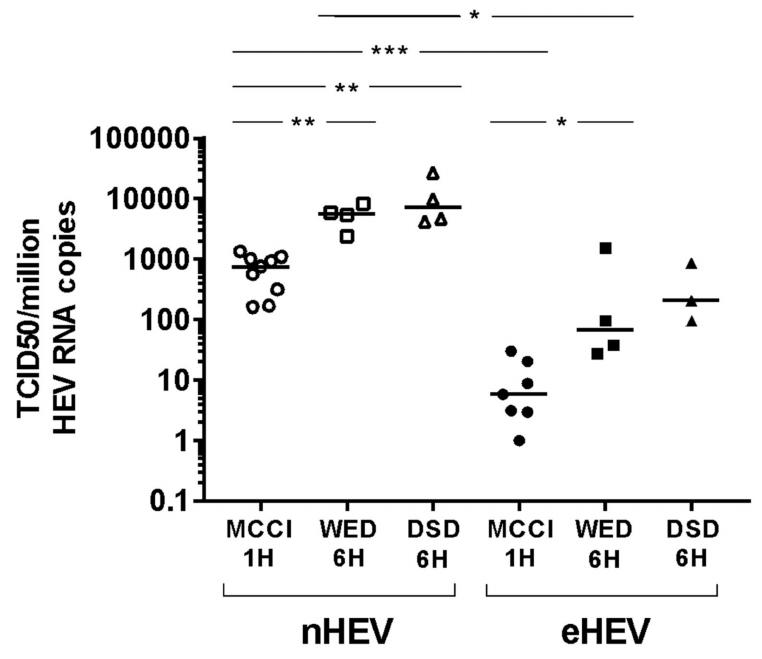
Figure 2. HEV3 RNA infectivity in di ff erent culture conditions. Tissue culture infectious dose 50 (TCID50) per million HEV RNA copies calculated for nHEV3 (empty symbols) and from the first-passage supernatant culture of the same strain on PLC / PRF / 5 cells, eHEV3 (filled symbols). Successive ten-fold dilutions of the viral suspensions were used to inoculate HepG2 / C3A cells, either during 1-h at room temperature in MCCI medium (circles) or for 6 h at 35.5 ◦ C in WED (squares) or DSD (triangles) medium. Cells were maintained in the same medium until day 10. The horizontal bars represent medians with range. * p < 0.05. ** p < 0.01. *** p <